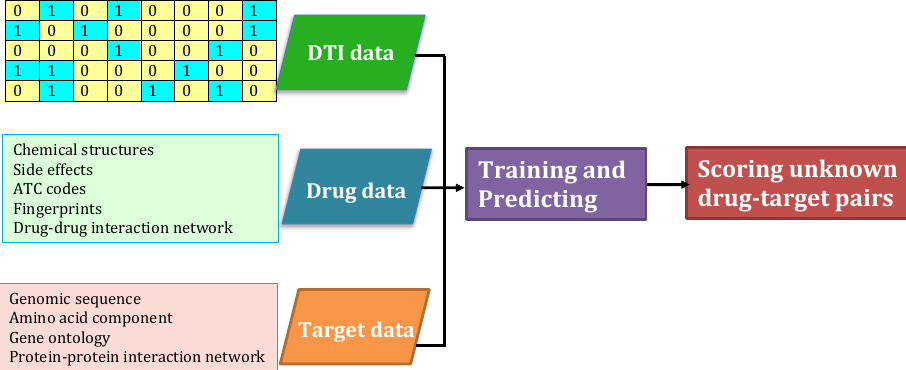
Figure 1. The flowchart of standard drug-target interactions (DTI) identification